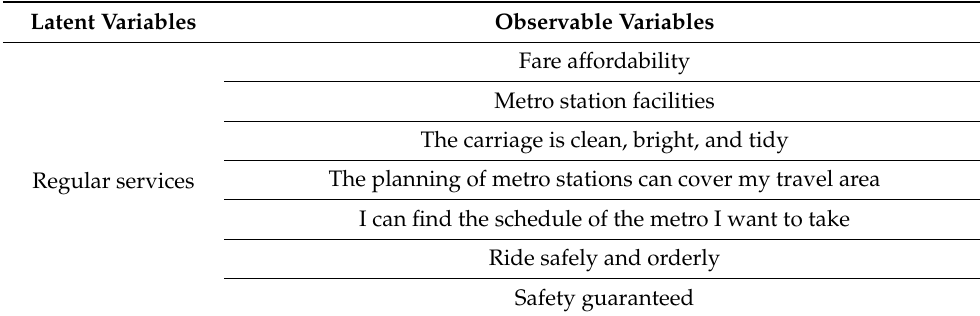
Table 1. Latent and observable